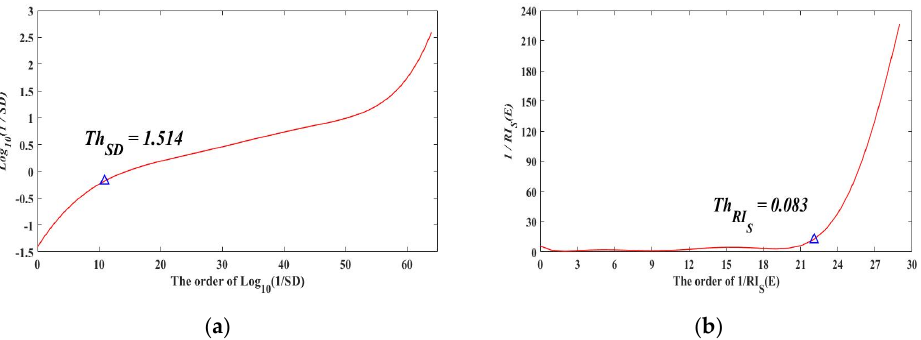
Figure 7. The optimal threshold of splitting evolution for the simulated dataset. The triangle symbol is located at the inflection point of the curve, and the equation represents the value of the corresponding variable at the inflection point. ( a , b ) are splitting degree and relative importance of split objects, respectively.